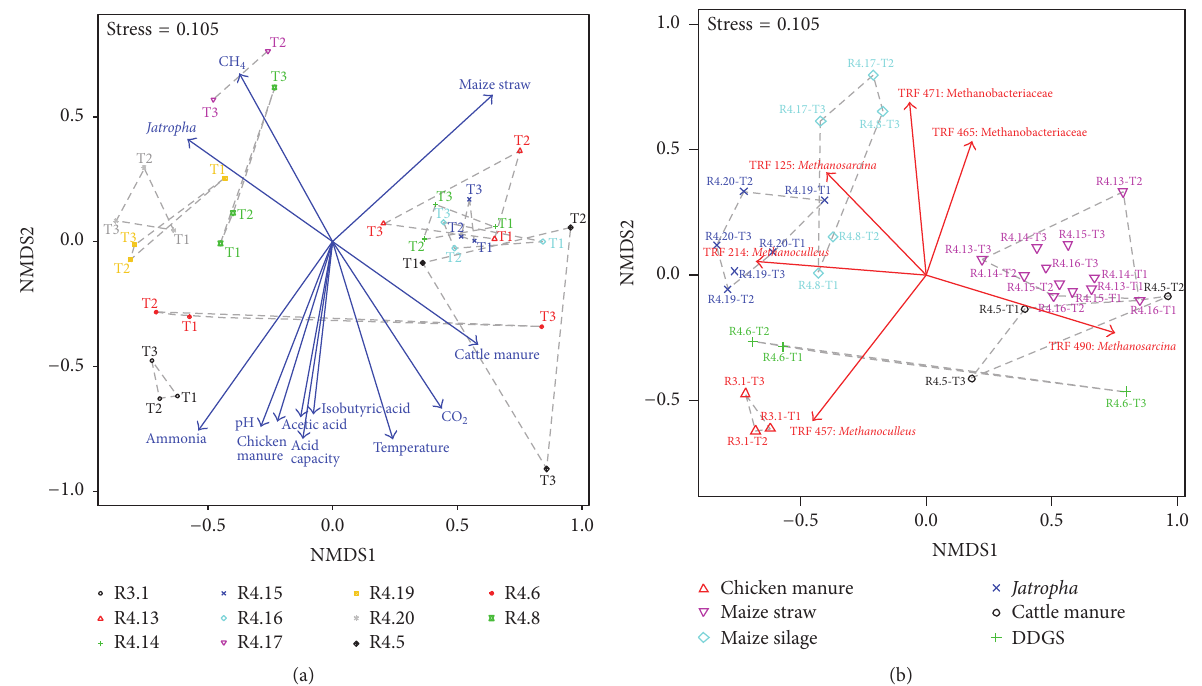
Figure 3: Nonmetric multidimensional scaling plots of T-RFLP profiles of mcrA amplicons digested with the restriction enzyme Hae III. (a) Blue arrows indicate the vectors of process parameters which shaped community differences the most (significance factors 𝑝 < 0.01 , tested by Monte-Carlo permutation against 1000 random data sets). (b) Samples from reactors fed with the same substrate are marked with the same color. Red arrows indicate vectors of single T-RF (significance factors 0.01 < 𝑝 < 0.05 ) which shaped the communities the